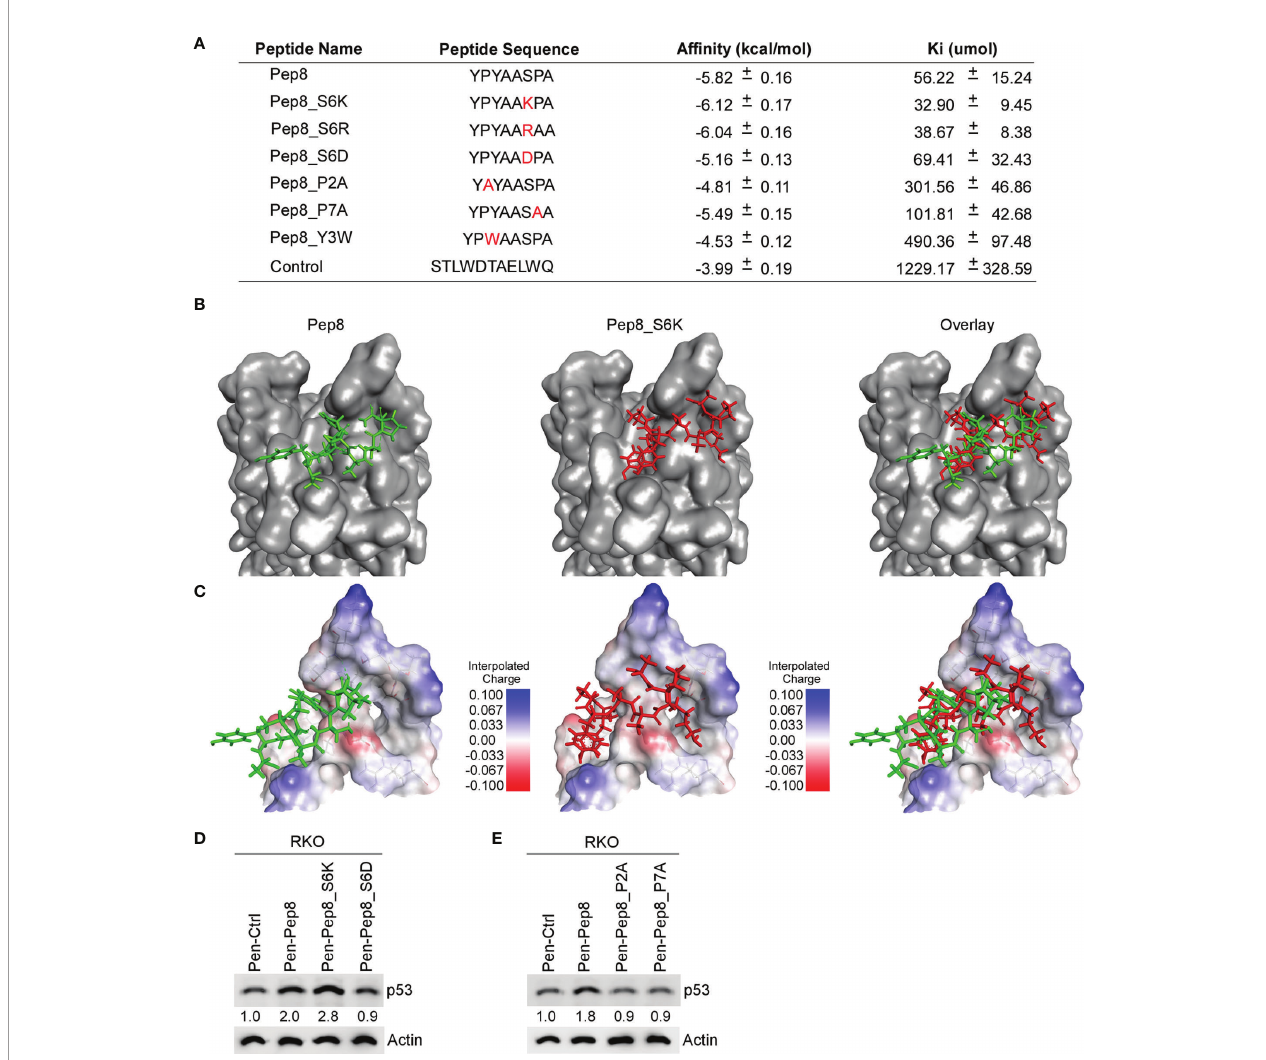
FIGURE 1 | Delineating key residues in Pep8 necessary for binding to eIF4E. (A) List of peptide names and sequences, as well as the calculated binding af fi nity and equilibrium dissociation constant (Ki) for each peptide as determined by AutoDock Vina. (B) Visualization of the binding mode for Pep8 and Pep8_S6K. (C) Visualization of the interpolated charge surface of eIF4E, and the corresponding peptide. (D, E) The levels of p53 and actin proteins were measured in RKO cells treated with 20 µM Penetratin fused peptides for 18